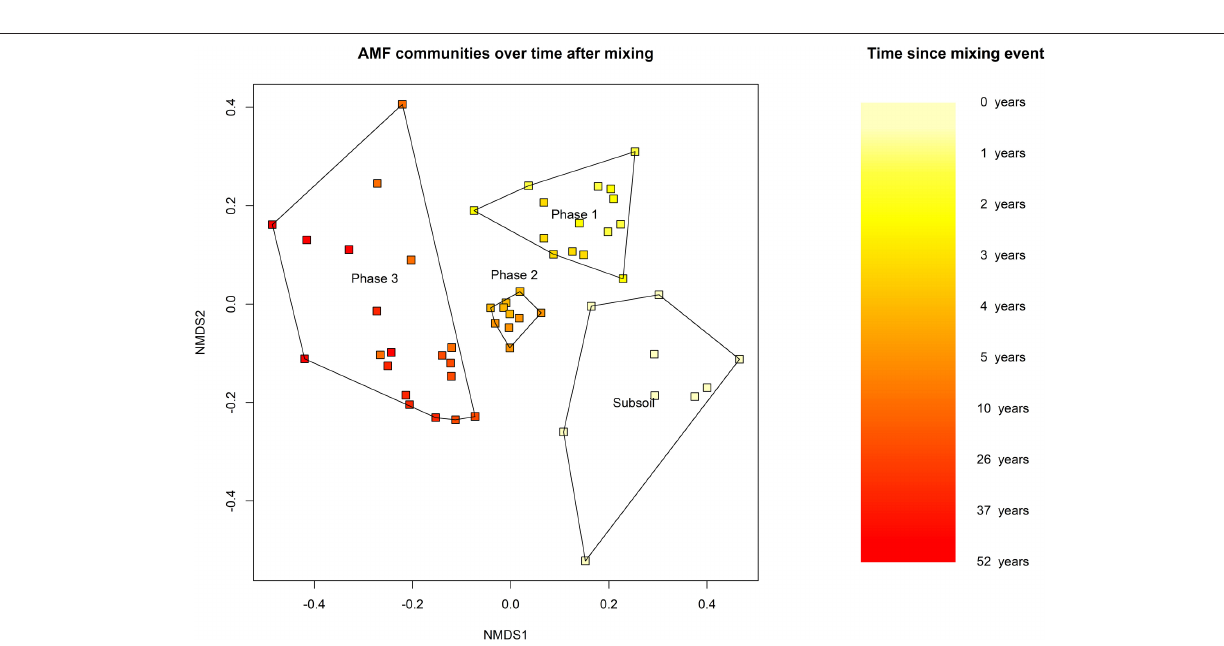
FIGURE 2 | Community ordination of AMF over time. Non-metric multidimensional scaling (NMDS) of a Bray-Curtis pairwise dissimilarity of the AMF communities. The OTU table was rarefied to 559 reads, the minimum amount of reads per sample and includes all chronosequence samples and subsoil samples from the unmixed field. Time since start of the recultivation is coded by color. The polygons encompass all samples from that group. Subsoil = 60–75cm, n = 9. Phase 1: 1–3 years, n = 15. Phase 2: 4–5 years, n = 10. Phase 3: 10–52 years, n =